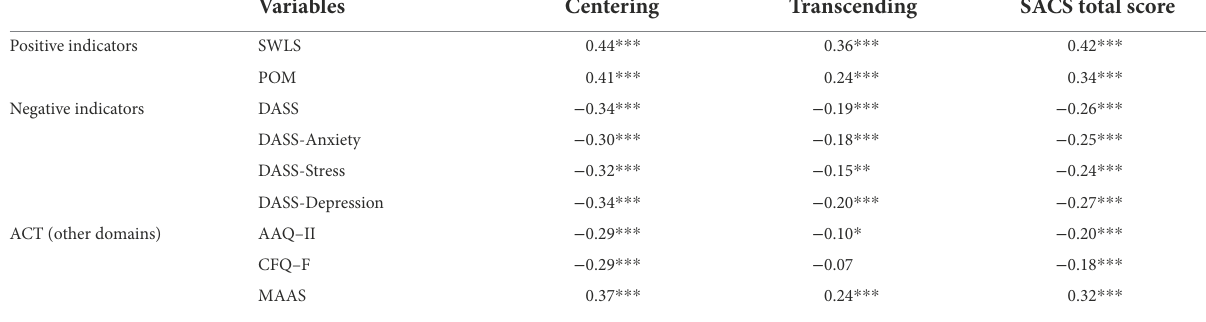
TABLE 4 Correlations for the SACS with other scales ( N =